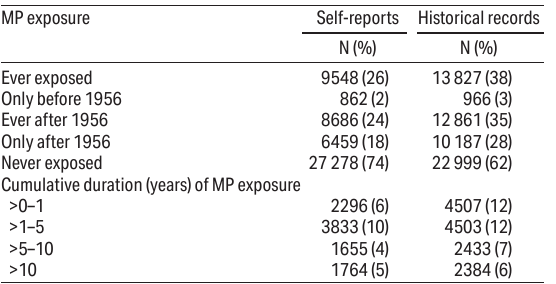
Table 2. Number and proportion of workers exposed to McIntyre Pow- der (MP) in the study cohort. The study cohort was created by linking a database of mining workers’ work history (Mining Master File) to healthcare records in Ontario, Canada. This cohort included 36 826 male miners.